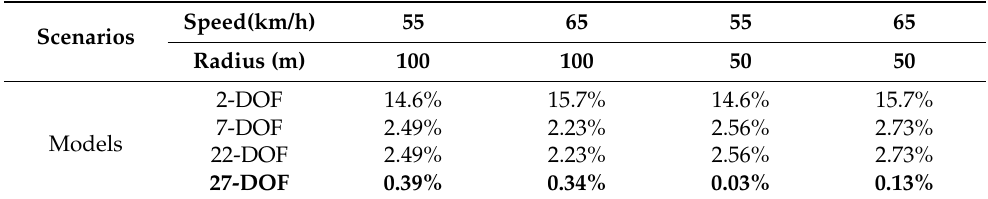
Table 4. Yaw velocity stable error in different scenarios of const